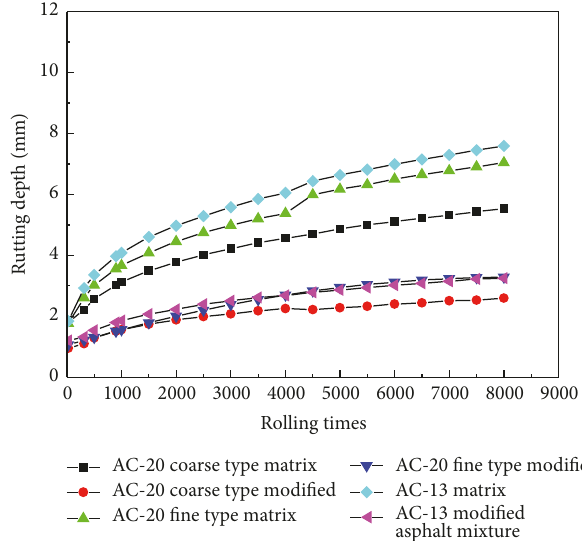
Figure 9: APA rutting depths of asphalt mixtures with 7% air voids at 50 ∘ C under immersing